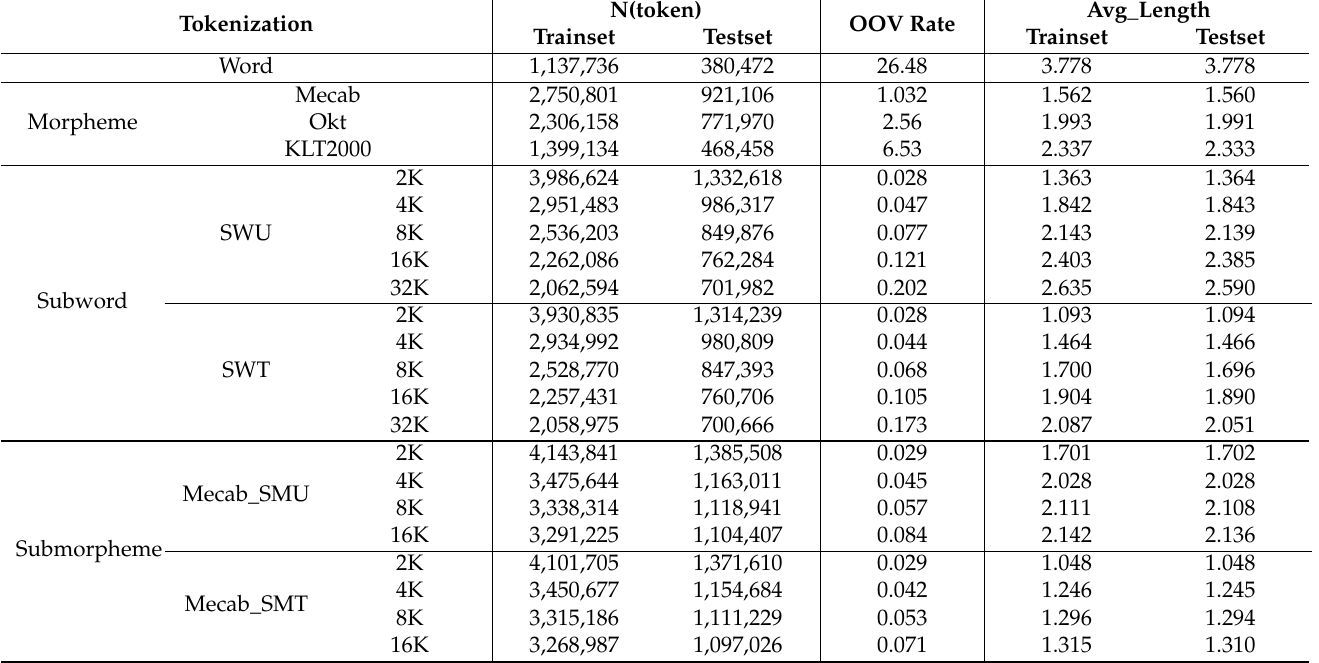
Table 2. Data distribution for